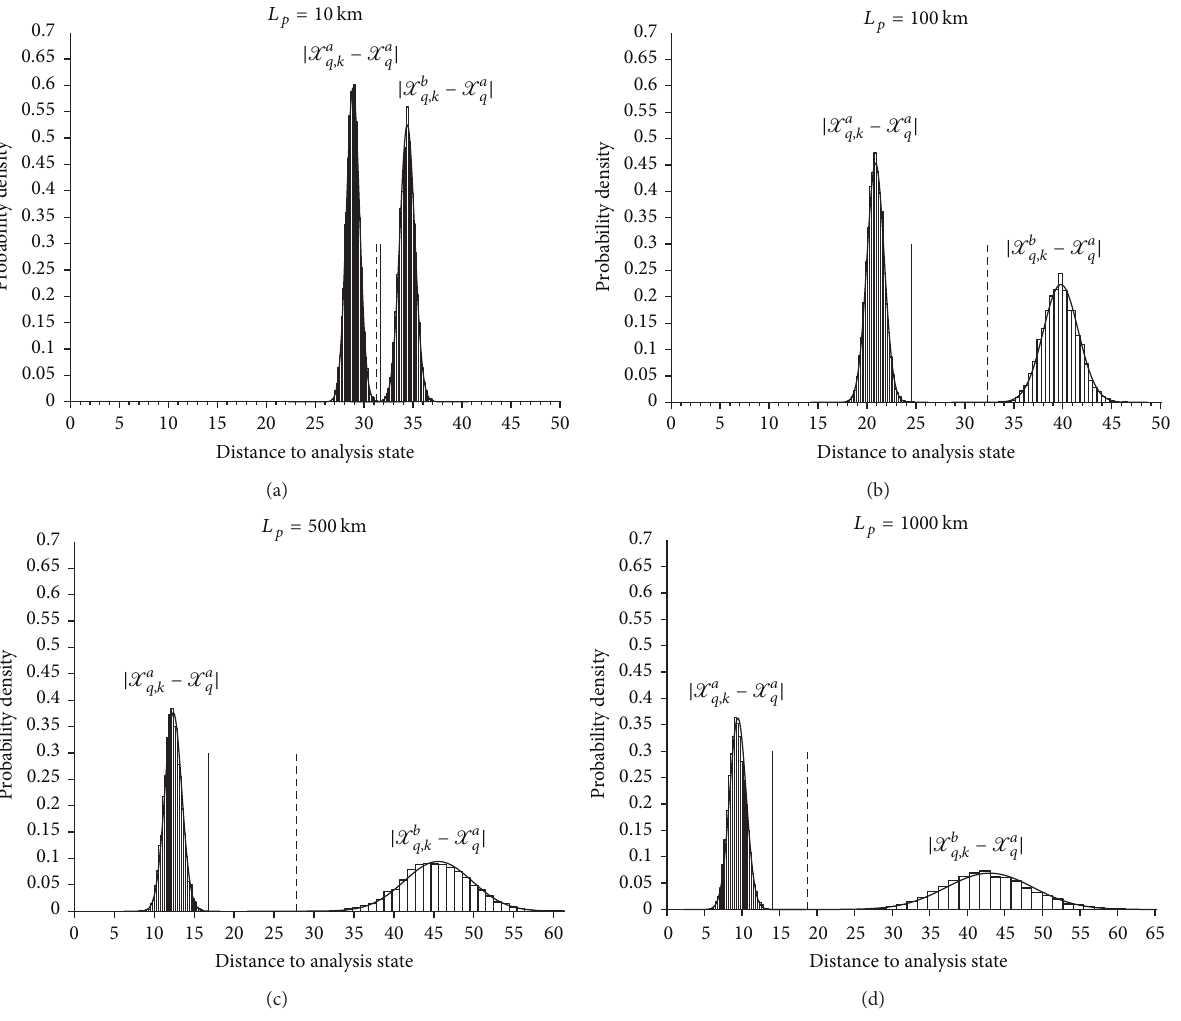
of 𝑞 ,𝑎 𝑞,𝑘 | X 𝑏 − X 𝑎 | is the vertical segment in dashed line. 𝑎 𝑞 ,𝑏 𝑞,𝑘 of 𝑞,𝑘 𝑞